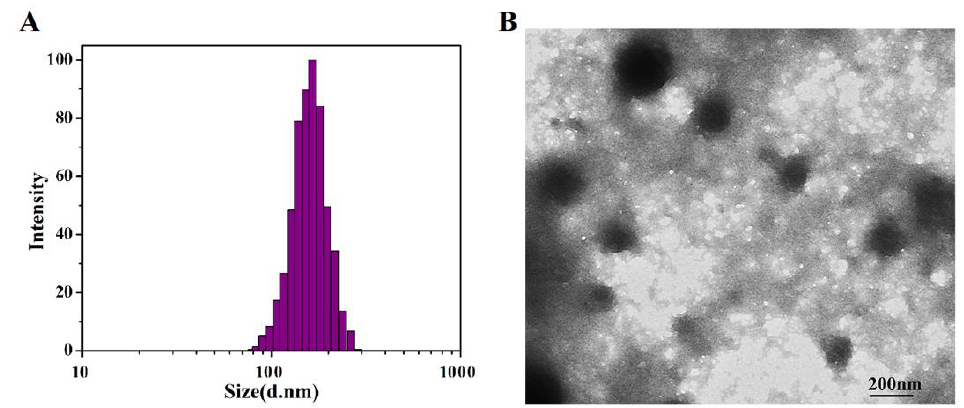
Figure 3. ( A ) Size distribution based on the intensity of SF-AGN and ( B ) transmission electron mi- crographs of SF-AGN nanospheres (magnification ×10,000).